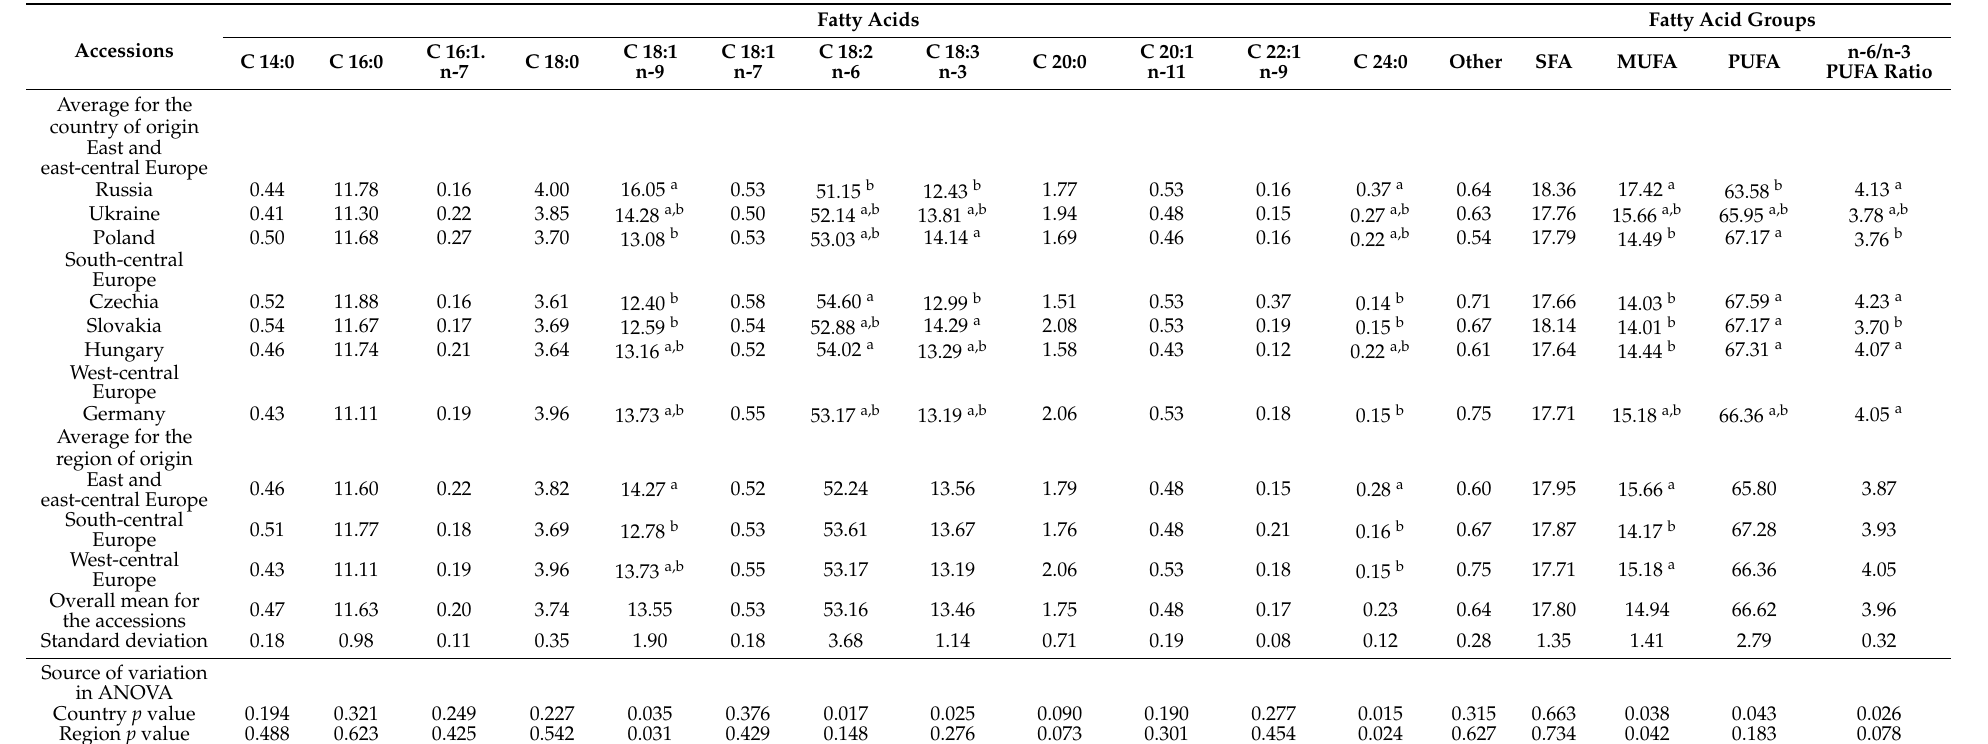
Table 4. Fatty acid composition (% of total fatty acids) in Vicia sativa seed